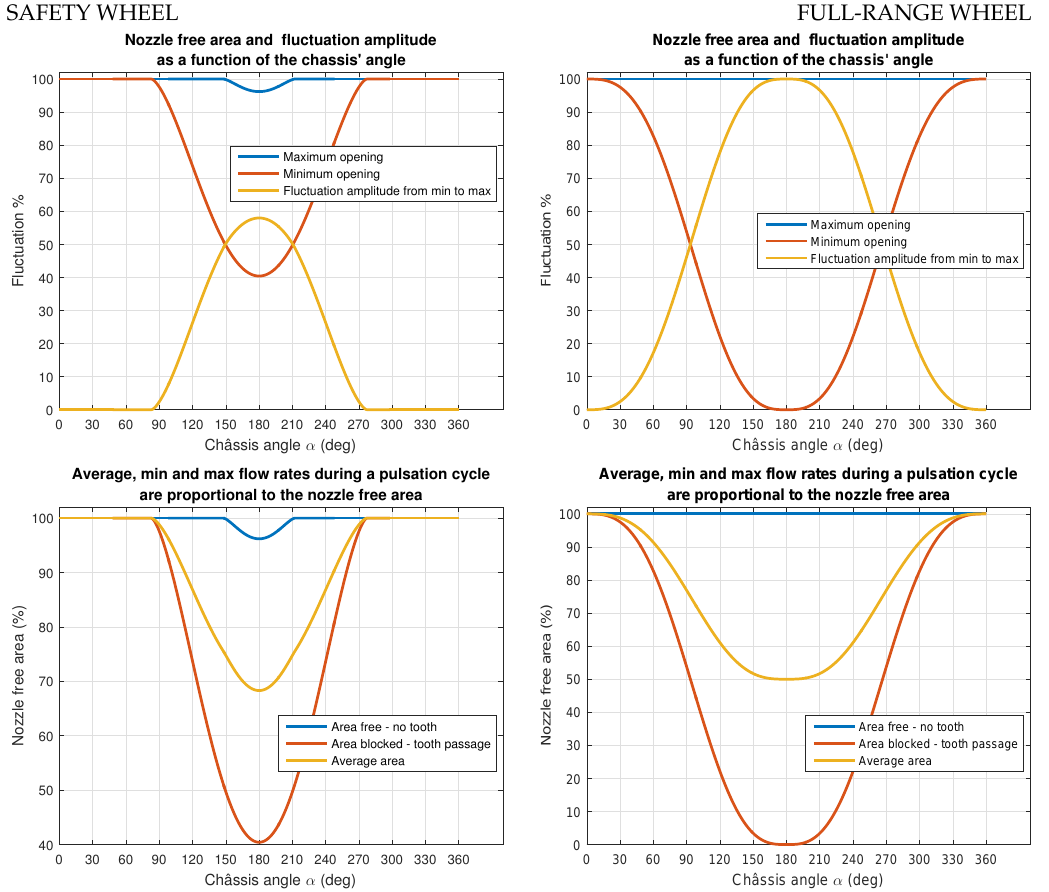
Figure 10. Percentage of covered surface of the jet critical section expressed as a function of the tilting angle α of the off-centre frame, and corresponding mass flows during the pulsation